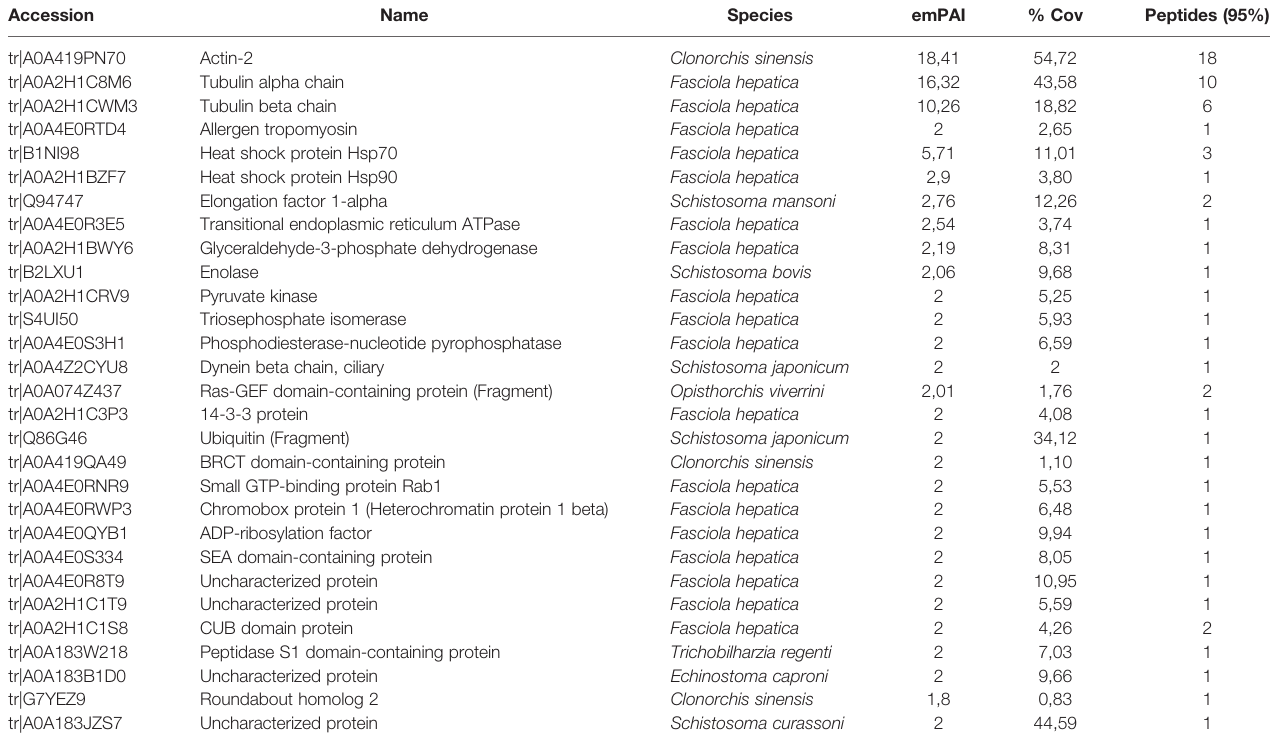
TABLE 2 | Identi fi cation of proteins within the EVs of F. hepatica NEJs in culture isolated by SEC and analyzed by